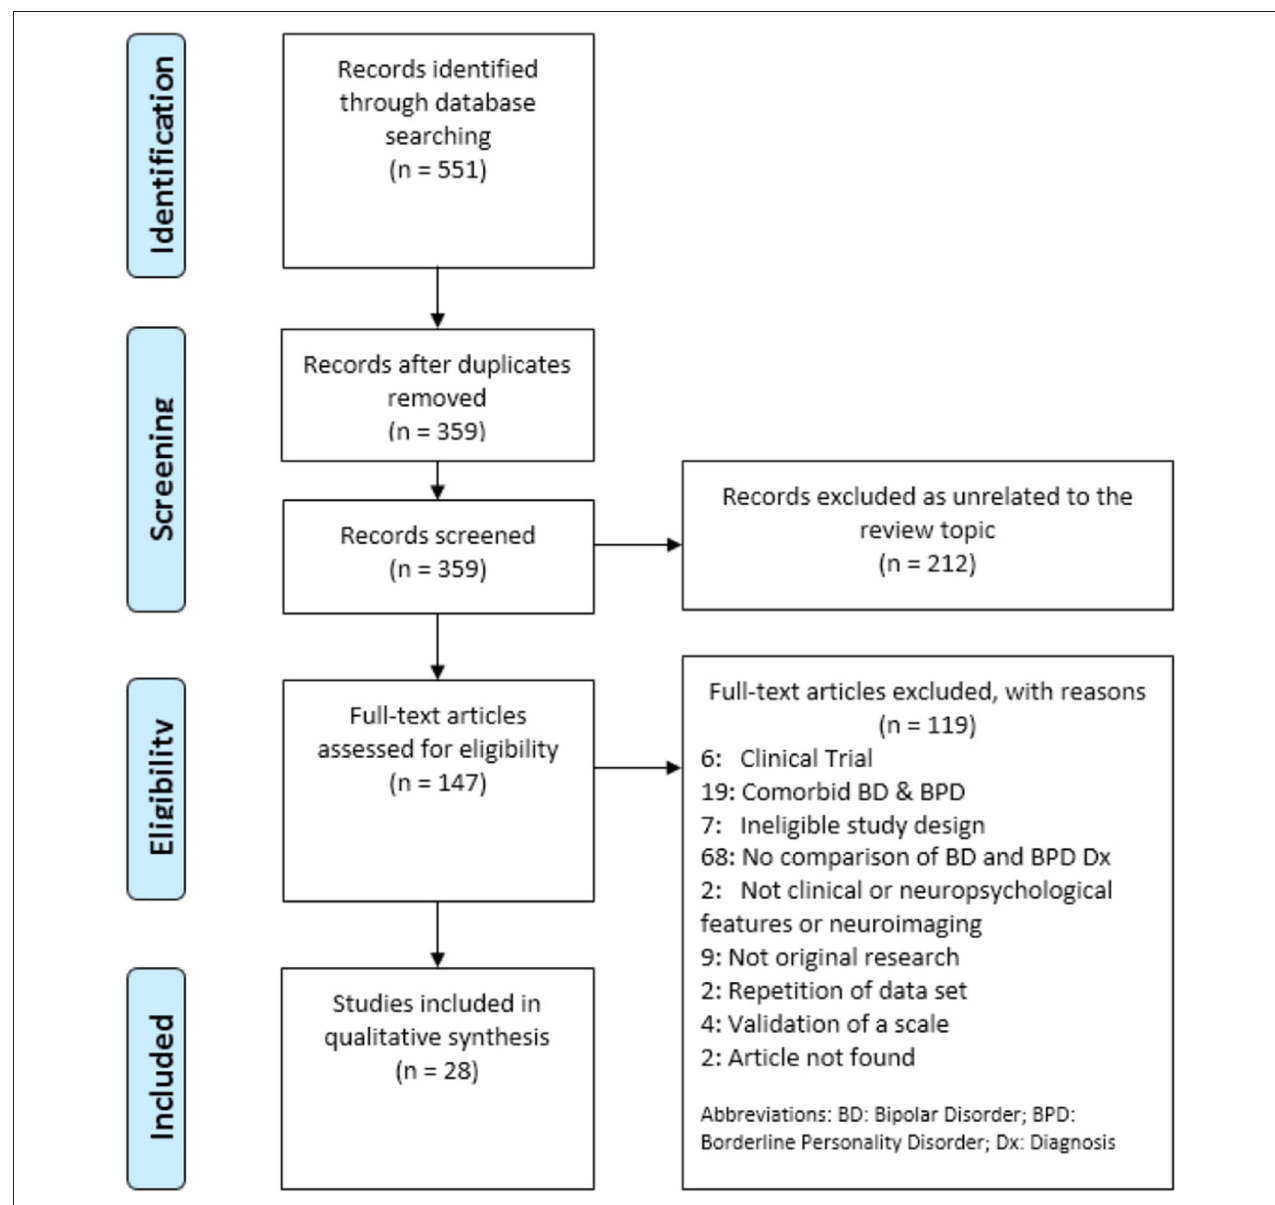
FIGURE 1 | PRISMA flow